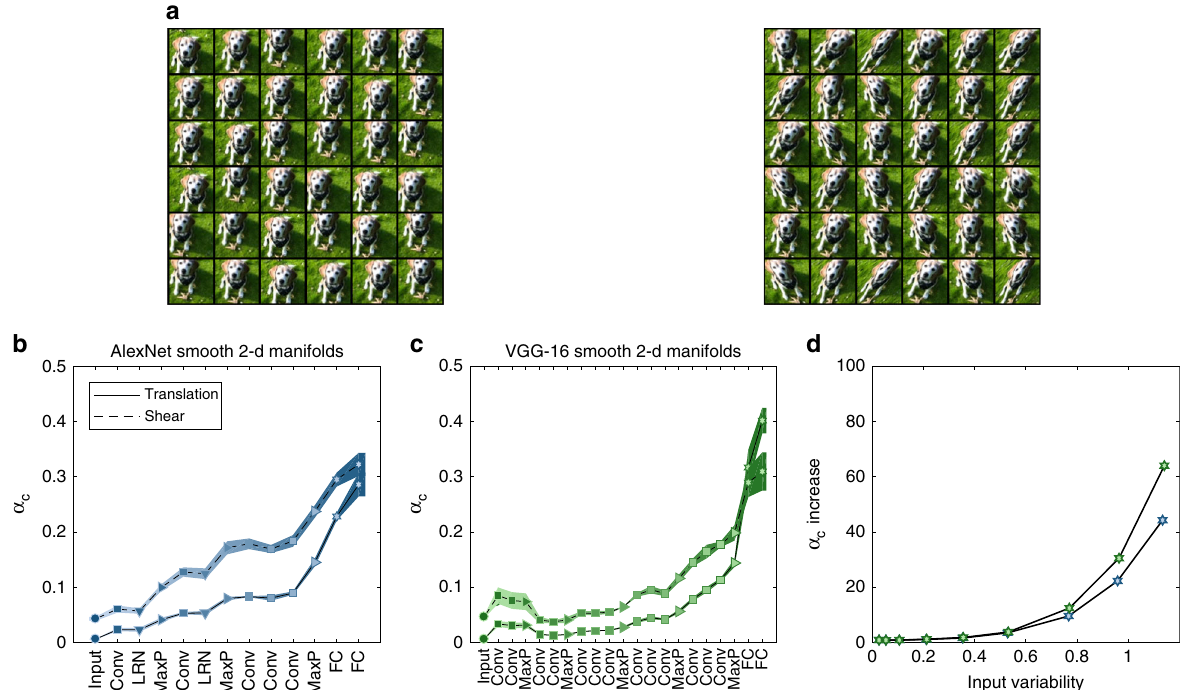
Fig. 5 Capacity of smooth manifolds from warped ImageNet images. a Illustration of smooth, densely sampled af fi ne transformed images; 36 samples from a 2-d translation manifold (left) and 2-d shear manifold (right). Each manifold sample is associated with a coordinate specifying the horizontal and vertical translation or shear of a base image, and corresponds to an image where the object is warped using the appropriate af fi ne transformation. b , c Classi fi cation capacity for 2-d smooth manifolds (full line: translation; dashed line: shear) along the layers of AlexNet ( b ) and VGG-16 ( c ). Line and markers indicate mean value over four different choices of 64 objects; surrounding shaded areas indicate 95% con fi dence interval. The x -axis labels provides abbreviation of the layer types. Marker shape represents layer type (circle — pixel layer, square — convolution layer, right-triangle — max-pooling layer, hexagon — fully connected layer, down-triangle — local normalization). Features in linear layers are extracted after a ReLU nonlinearity. Color (blue — AlexNet, green — VGG-16) changes from dark to light along the network. d Capacity increase from the input (pixel layer) to the output (features layer) of AlexNet (blue markers) and VGG-16 (green markers) for 2-d translation smooth manifolds. The capacity increase is speci fi ed as ratio of capacity at the last layer relative to the pixel layer ( y -axis), at different levels of stimuli variation measured using Supplementary Eq. (3) at the pixel layer ( x